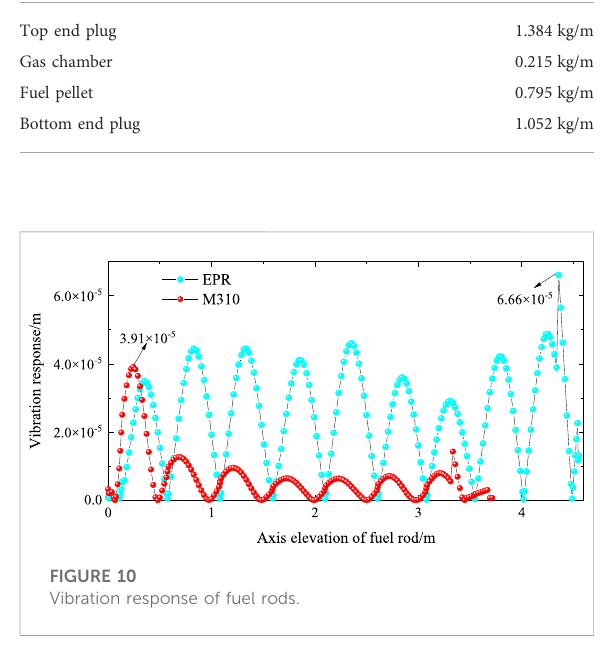
FIGURE 10 Vibration response of fuel